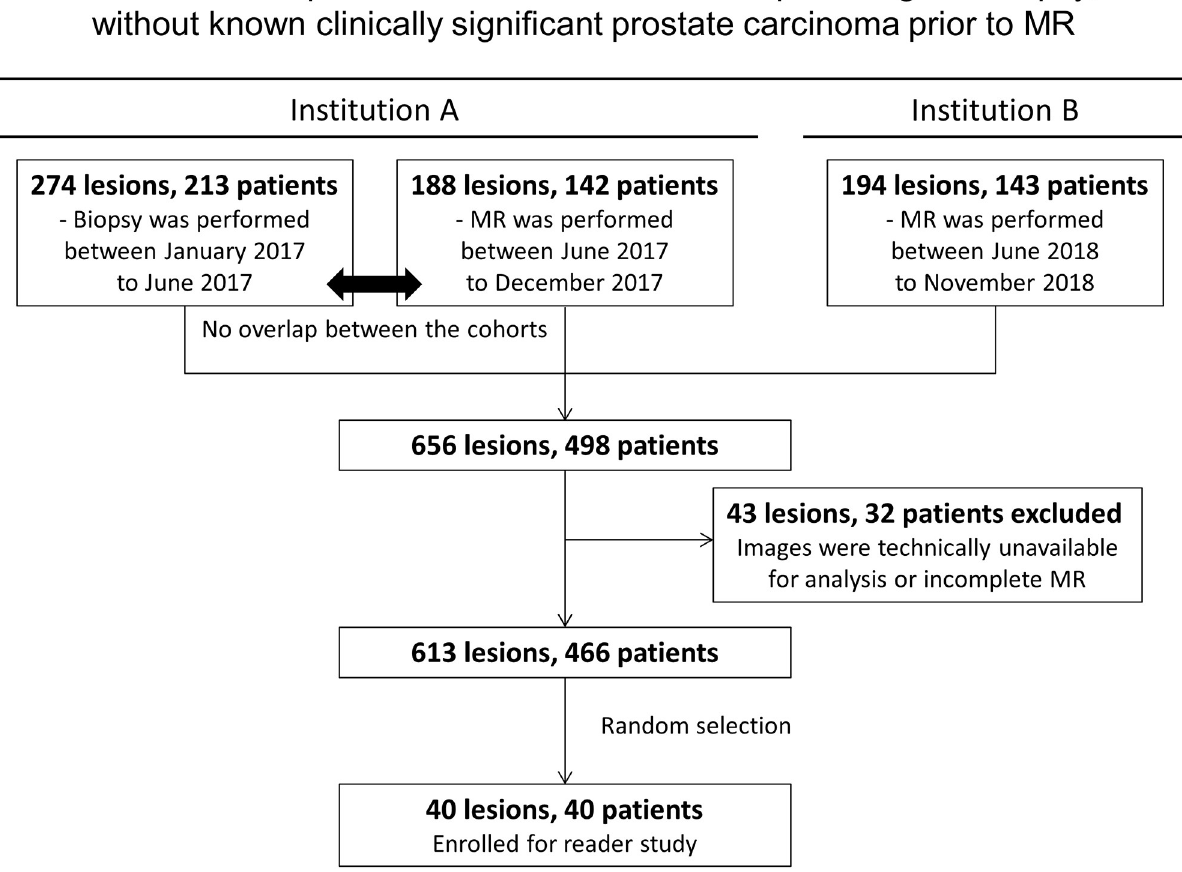
Fig 1. Patient’s enrollment flowchart. At Institution A, 213 patients with a total of 274 lesions underwent biopsy from January 2017, to June 2017, and 142 patients with a total of 188 lesions underwent MRI from June 2017, to December 2017. At Institution B,143 patients with a total of 194 lesions who underwent MRI from June 2018, to November 2018, were enrolled in our study. Thirty-two patients with a total of 43 lesions were excluded because images were unavailable for analysis or MRI was incomplete. A total of 466 patients with a total of 613 lesions were evaluated in this study. Forty patients, each with 1 lesion (40 total lesions) were randomly selected from this cohort for the multireader study.